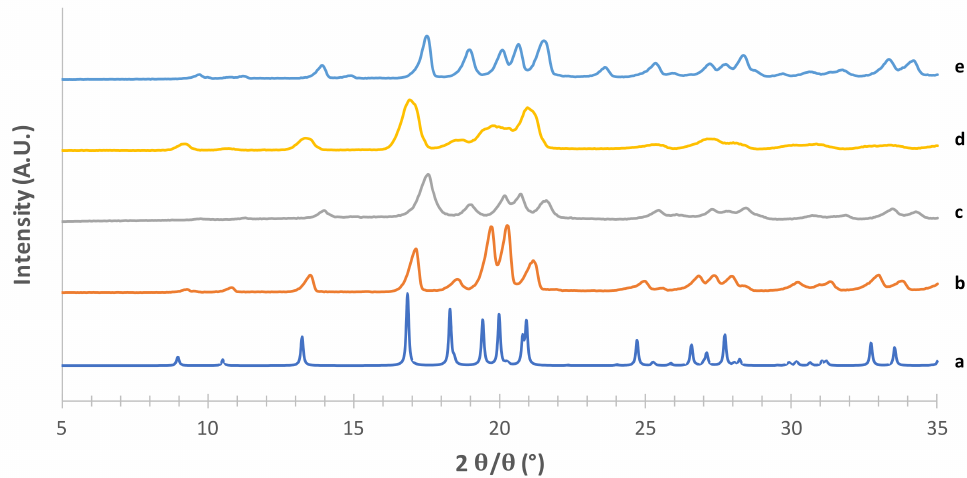
Figure 6. PXRD patterns of mannitol α form recorded at (b) time zero; (c) 1 month; (d) 12 months